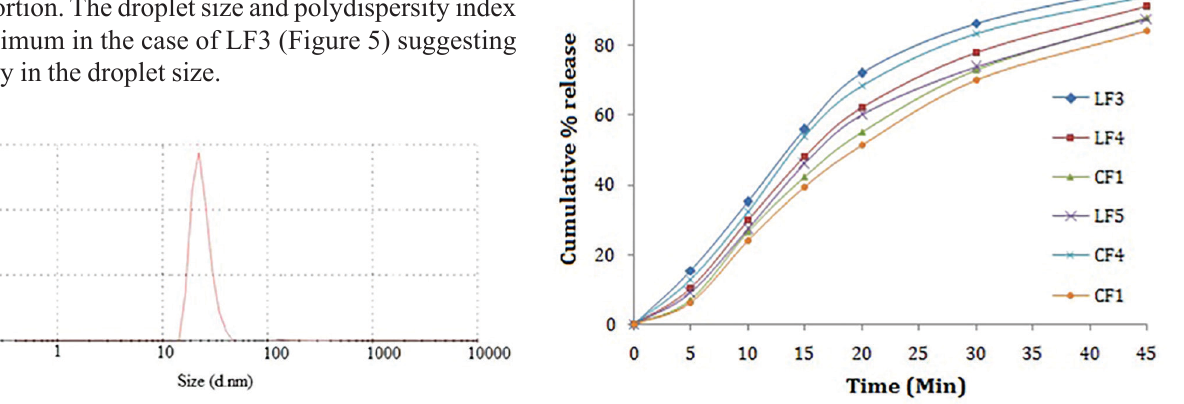
FIGURE 6 - Dissolution profile of optimized liquid SNEDDS. Data are expressed as mean ( n =